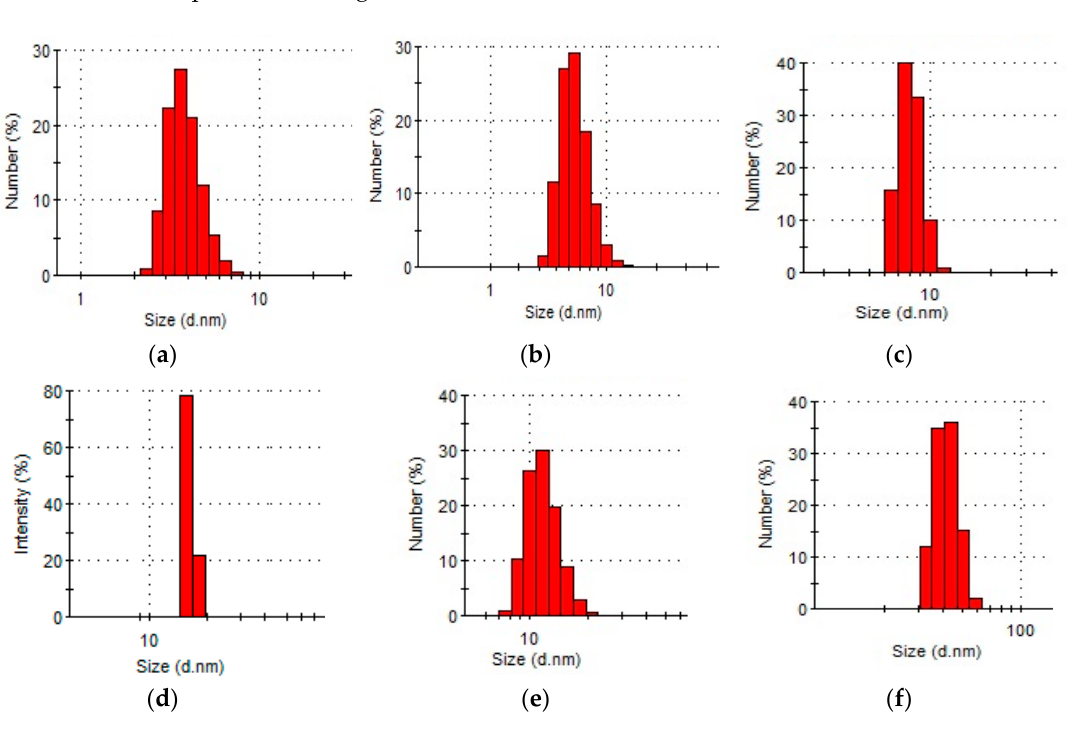
Figure 4. Average hydrodynamic size distribution of AuNPs stabilized by synthetic and natural polymers at 25 °C: ( a ) PVP 10 kDa, ( b ) PVP 40 kDa, ( c ) PEG 40 kDa ( d ) gellan, ( e ) κ -carrageenan, ( f ) welan ; [HAuCl 4 ] = 0.01 mM.